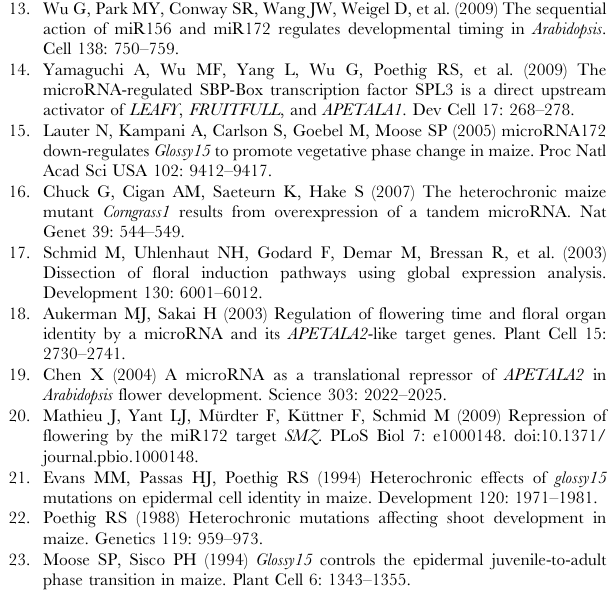
Table S1 Densitometry of band intensity on RNA blots from various species hybridized sequentially with probes miR156, miR157 and miR172. Values normalized to the intensity of tRNA met .